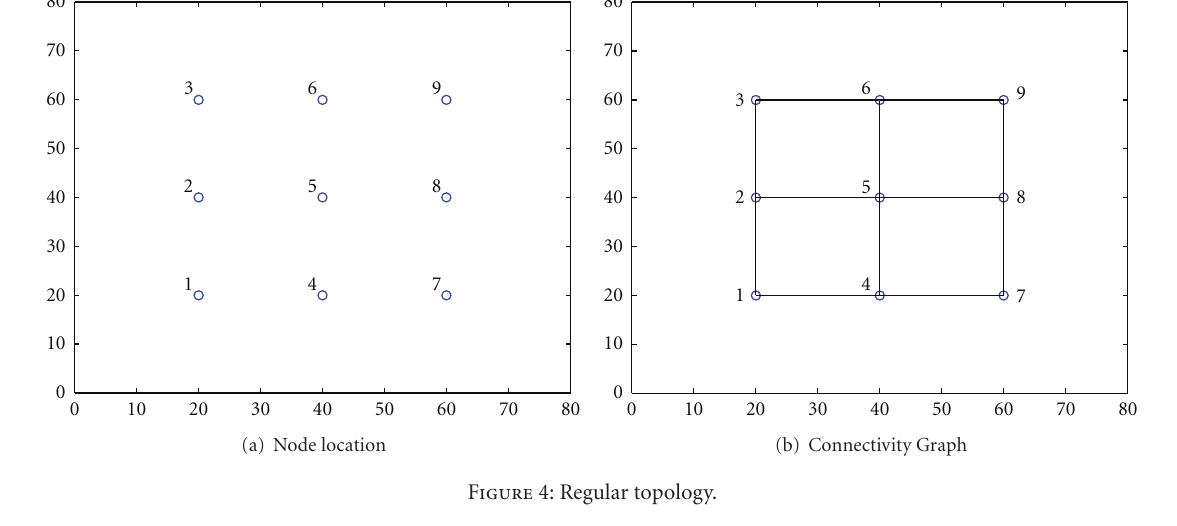
Figure 4: Regular topology.